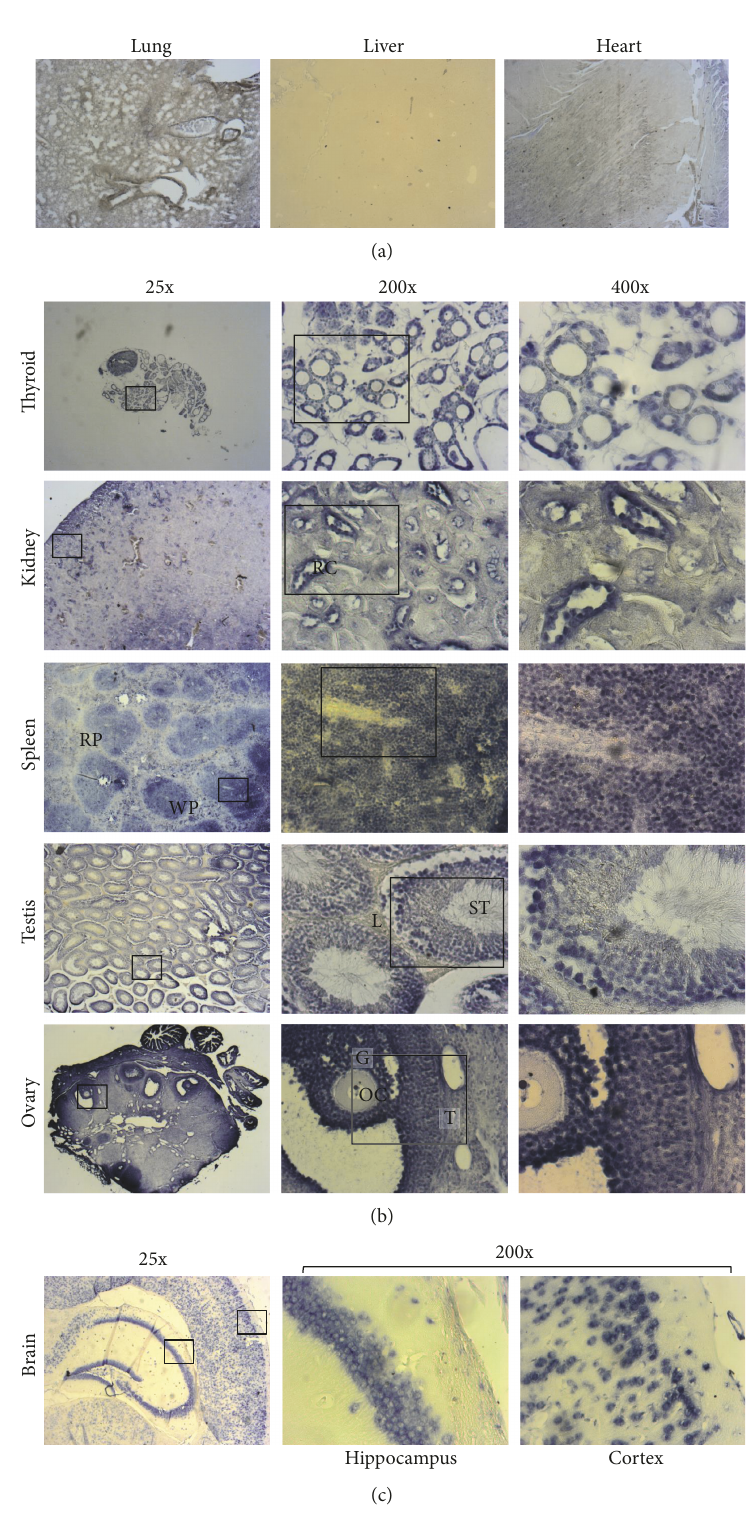
Figure 4: Cell type-speci fi c expression of Klhl14-AS in adult mouse organs. In situ hybridization was performed on para ffi n-embedded sections with a probe recognizing all Klhl14-AS isoforms (for details, see Materials and Methods). (a) The lung, liver, and heart are negative for Klhl14-AS staining. 25x magni fi cations are shown. (b) The thyroid, kidney, spleen, testis, and ovary are positive for Klhl14-AS staining. For each organ, three di ff erent magni fi cations are shown: 25x, 200x, and 400x. 200x magni fi cations correspond to the areas boxed in 25x pictures, while 400x magni fi cations correspond to areas boxed in 200x pictures. RC: renal corpuscle; RP: red pulp; WP: white pulp; L: Leydig cells; ST: seminiferous tubule; OC: oocyte; G: granulosa cells; T: thecal cells. All the images are reduced by 70% compared to the original ones. Data are representative of three independent